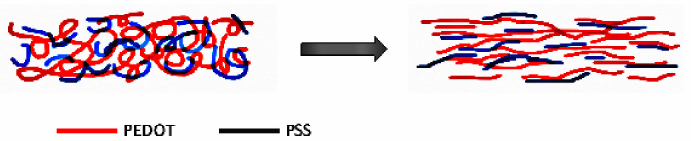
Figure 3. Conformational change of poly(3,4-ethylenedioxythiophene) polystyrene sulfonate (PE- DOT:PSS) after solvent (ethylene glycol (EG) or dimethyl sulfoxide (DMSO))